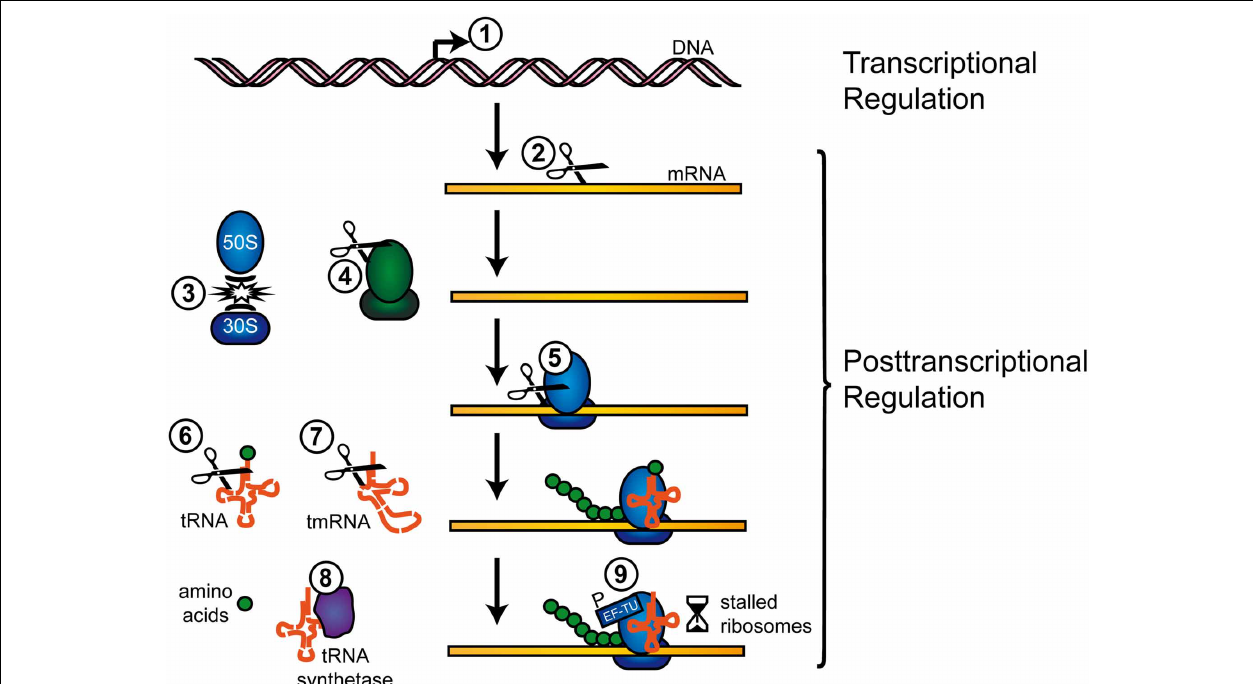
FIGURE 1 | Regulation of transcription and translation by TA systems. TA systems can regulate gene expression on a transcriptional and post-transcriptional level, as follows (examples in parentheses): (1) Canonical transcriptional gene regulation by DNA binding (MqsR). (2) Cleavage of free mRNA transcripts (MazF, ChpBK, PemK, HicA). (3) Inhibition of ribosome